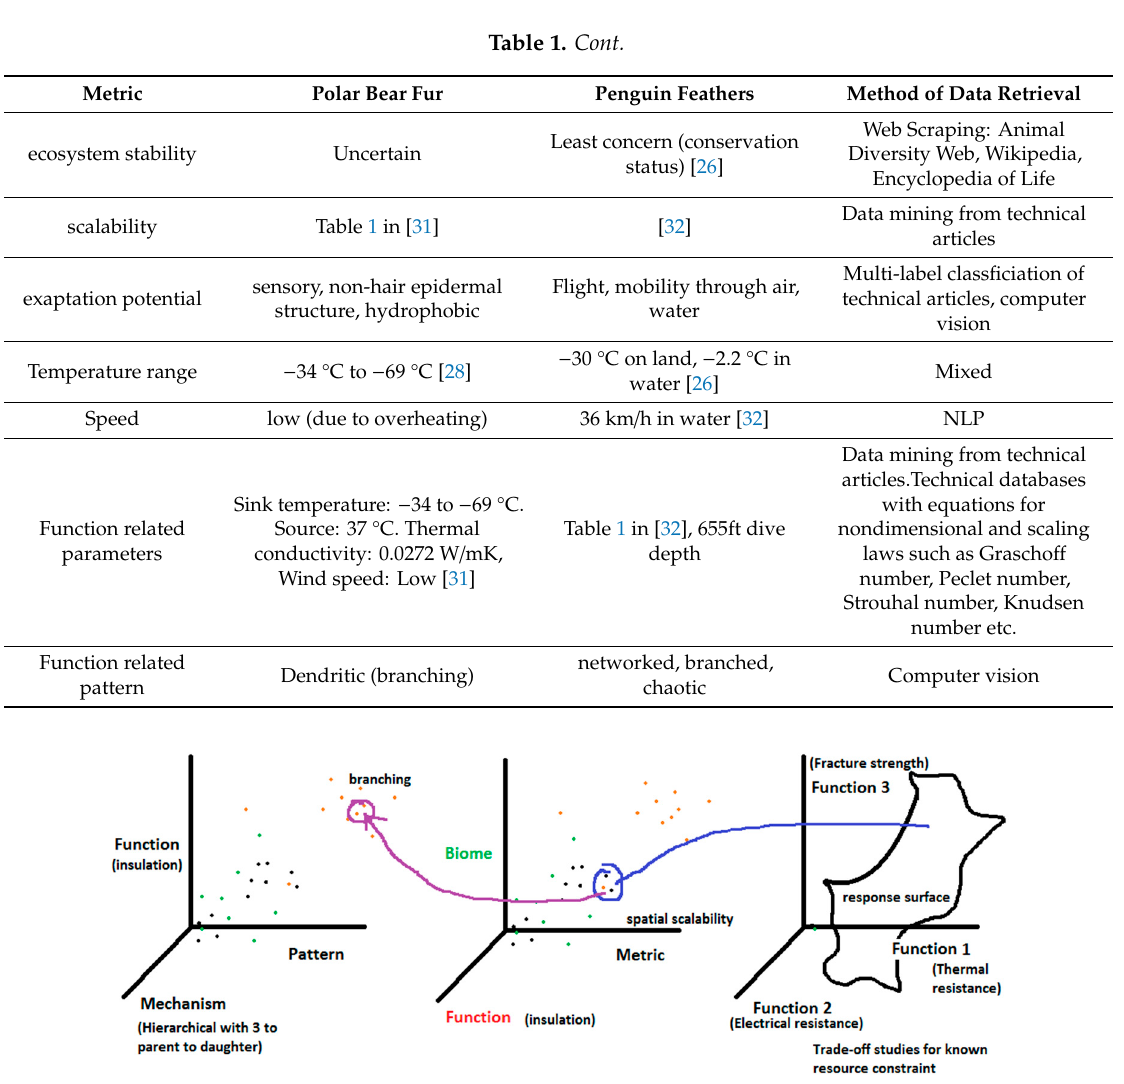
Figure 3. Sketch of Periodic Table of Life (PeTaL) data visualization process for